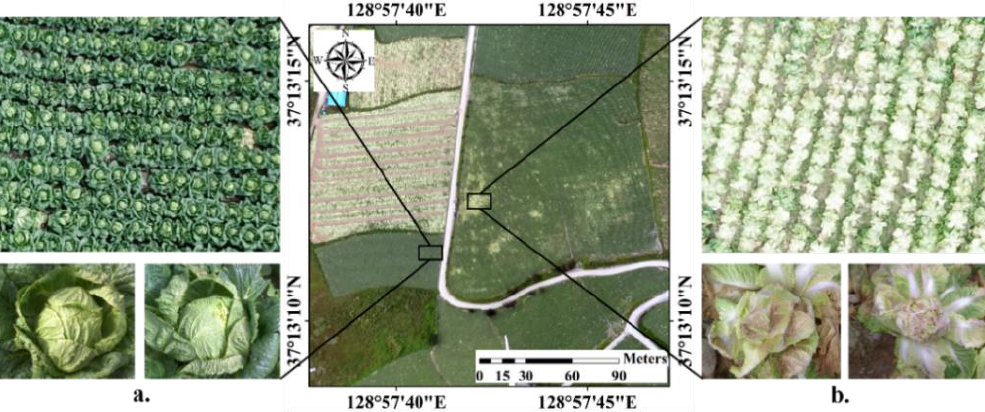
Figure 2. Kimchi cabbage cultivation status at the study site: ( a ). is a case with healthy (good) growth; and ( b ). is a case with unhealthy (poor) growth.